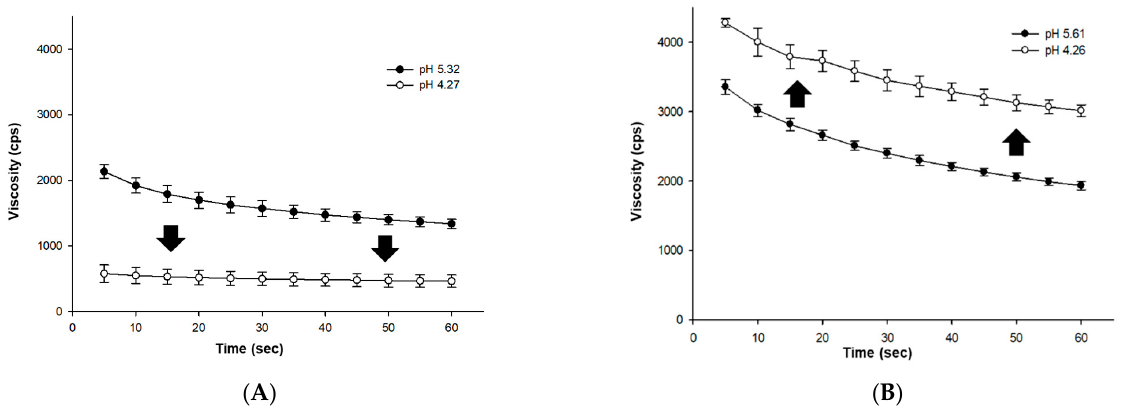
Figure 4. Effect of pH on the apparent viscosities of ( A ) ISP (isolated soy protein) and ( B ) PP (pea protein) solutions (5%, w / w ) after 12 h of fermentation.